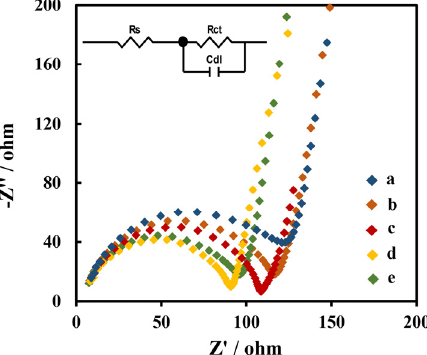
Figure 3. EIS of different nanometer-material-modified GCE: GCE (a); Chi/MWCNTs/GCE (b); Chi/MWCNTs − CTAB/GCE (c); Chi/HFs/MWCNTs − CTAB/GCE (d); and Chi/HFs − Lac/MWCNTs − CTAB/GCE (e), with a frequency range from 10 2 to 10 6 Hz in 0.1 M KCl solution containing 5 mmol L − 1 [Fe(CN) 6 ] 3 − /4 − . (Inset: Randle’s equivalent circuit. Rs: solution resistance; R ct : electron transfer resistance; C dl : double-layer capacitance).